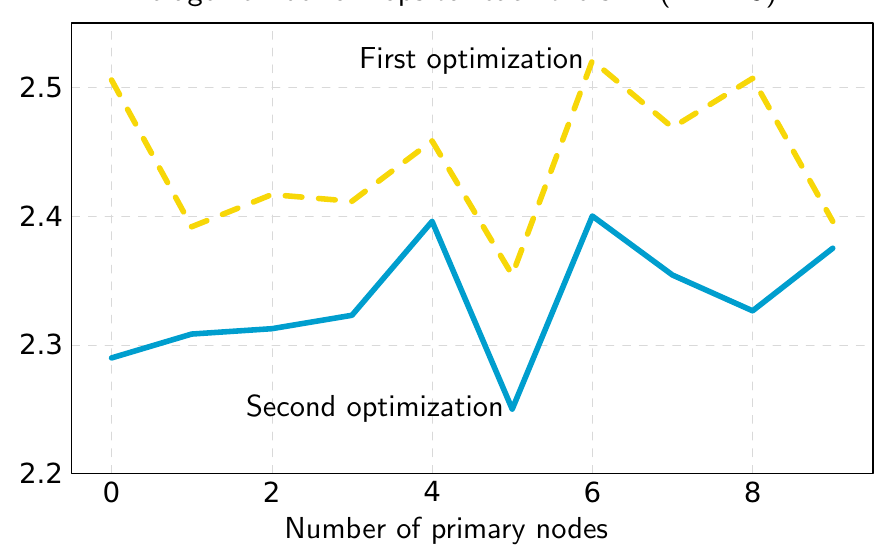
Figure 5. Minimum average number of hops for the N = 49 scenario of Figure 1 after the first and second